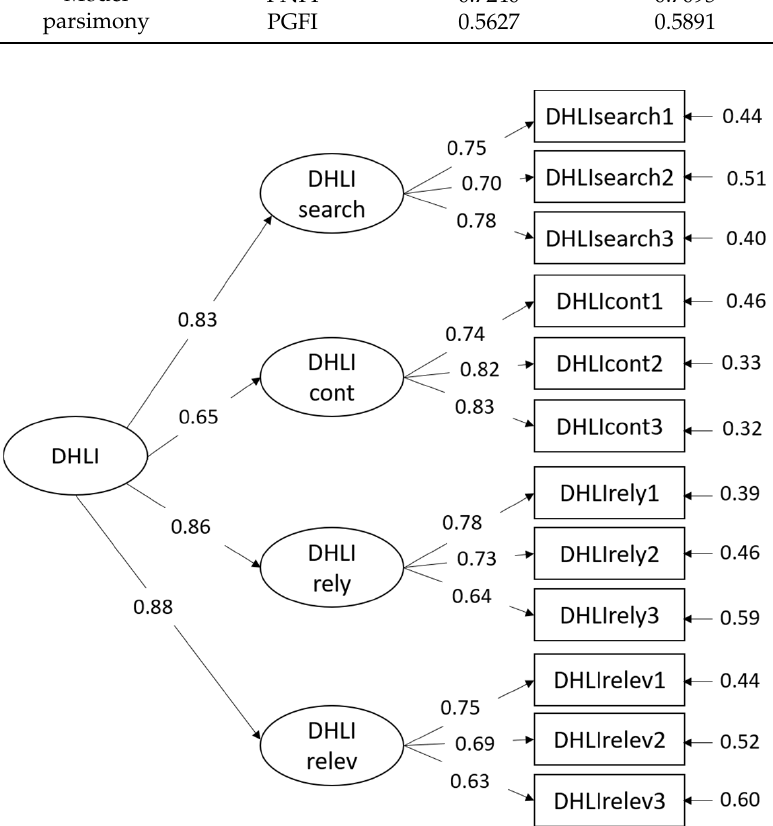
Figure 1. Structural Equation Models